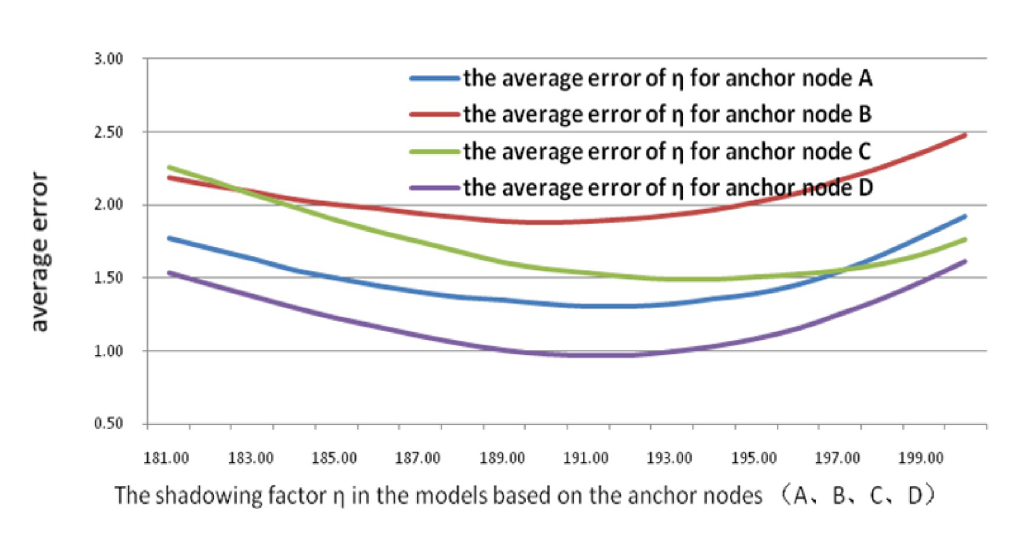
Figure 8. The formulation-relationship betweenηand